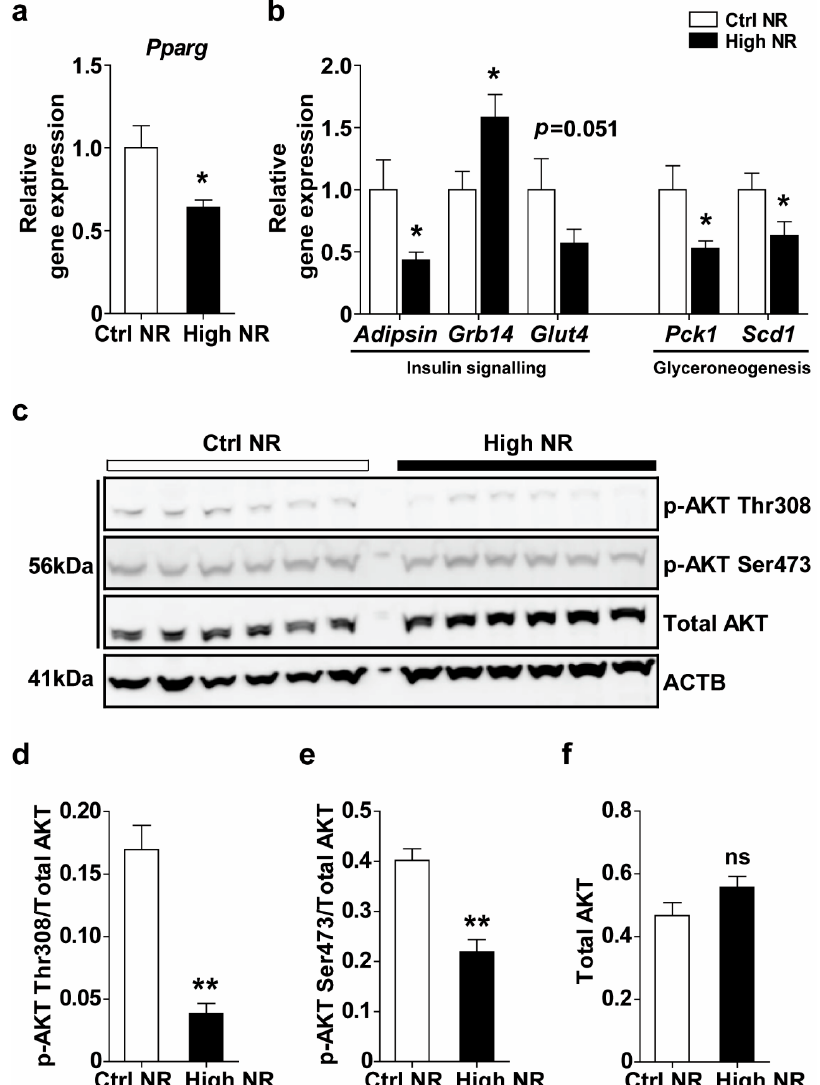
Figure 3. High NR feeding results in a lowered proliferator-activated receptor γ (PPAR γ ) expression signature. Relative gene expression of PPAR γ ( a ) and its targeted genes ( b ) (normalized to the reference genes, n = 10–12 per treatment). Phosphorylation and total AKT in eWAT were measured by immunoblotting, using ACTB as a loading control ( c ). Densitometry analysis on the ratio of p-AKT Thr308/AKT ( d ), p-AKT Ser473/AKT ( e ) and total AKT/ACTB (f) ( n = 6 mice per treatment). Control NR: white bar; high NR: black bar. Data are analyzed using Student’s t -test (a, b) or Mann–Whitney test (d-f) and presented as mean ± SEM. * p < 0.05, ** p < 0.01.